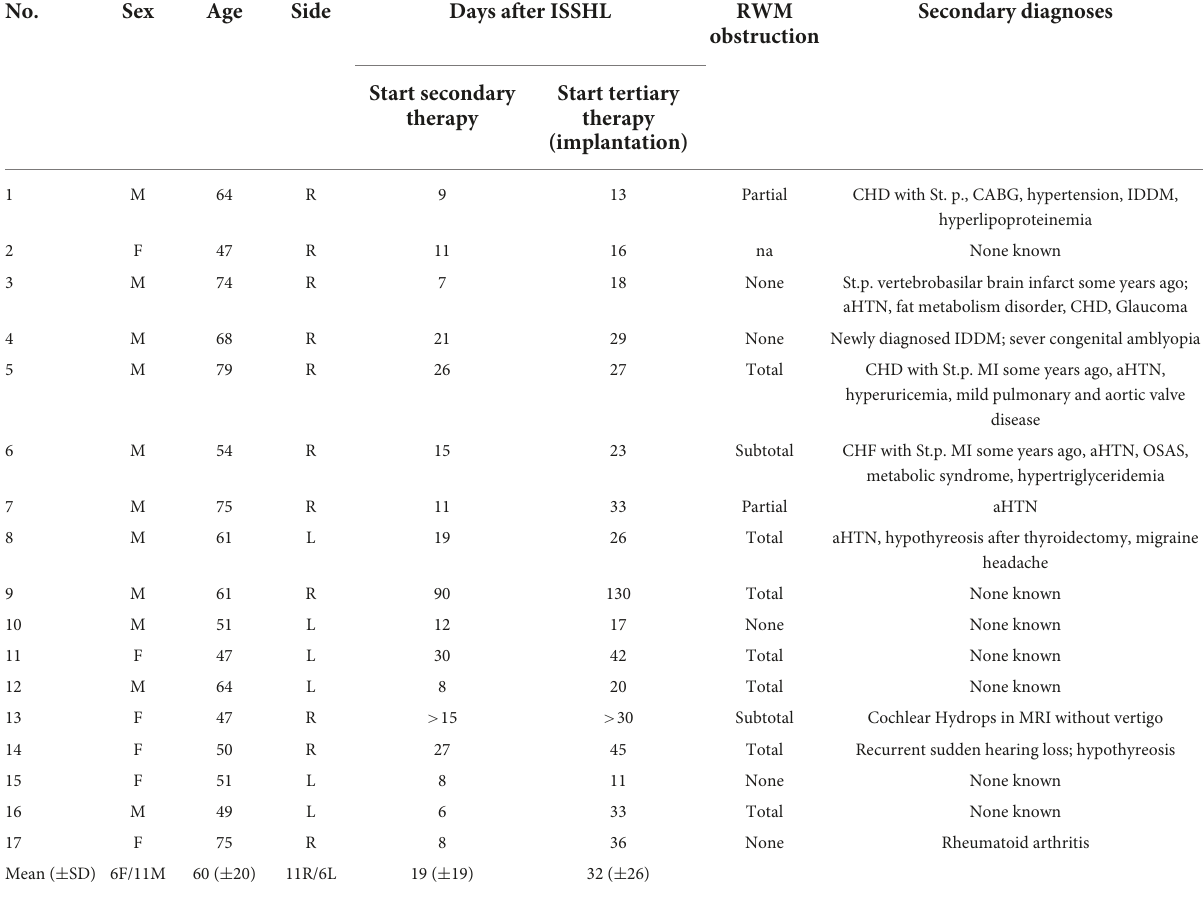
TABLE 1 Summary of demographic data, medical conditions, and intraoperative findings at tympanoscopy.